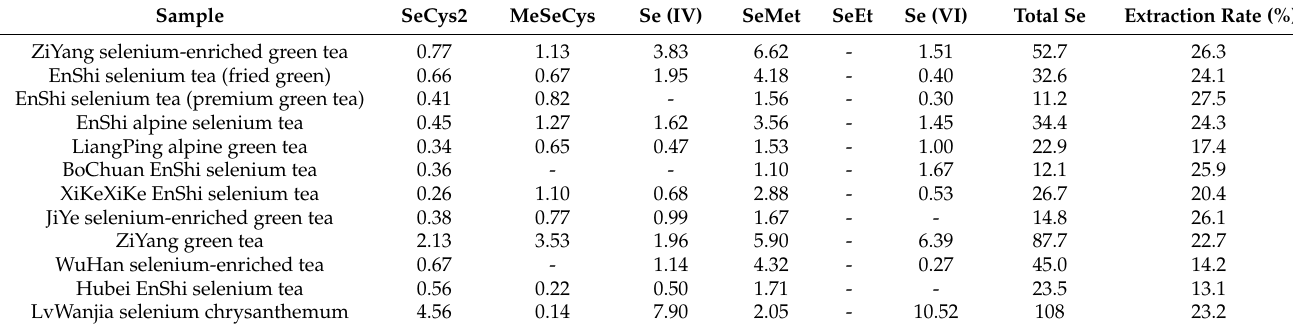
Table 4. Selenium speciation in selenium-enriched tea extract ( µ g kg − 1 ).